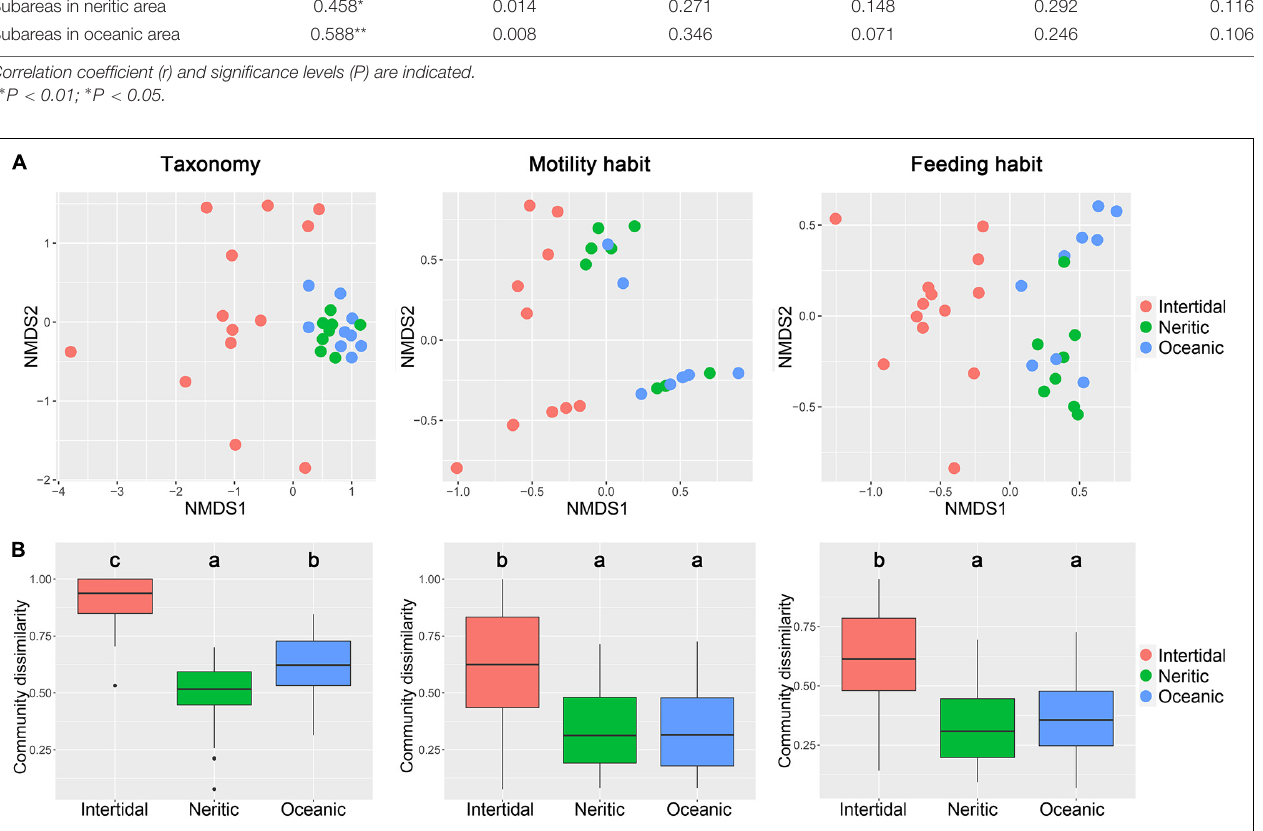
FIGURE 2 | Comparison of ciliate communities in terms of taxonomy, motility, and feeding habits compositions among the three areas in the SCS. (A) Non-metric multidimensional scaling (NMDS) ordination of samples in the three areas based on Bray–Curtis dissimilarity. (B) Dissimilarity of ciliate communities among the samples in each